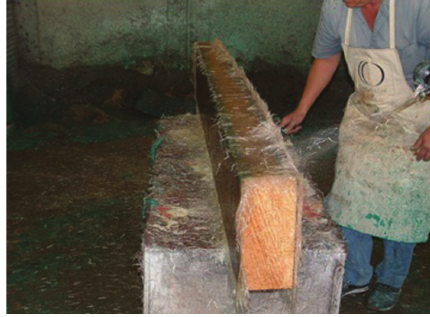
Figure 1: SFRP application.